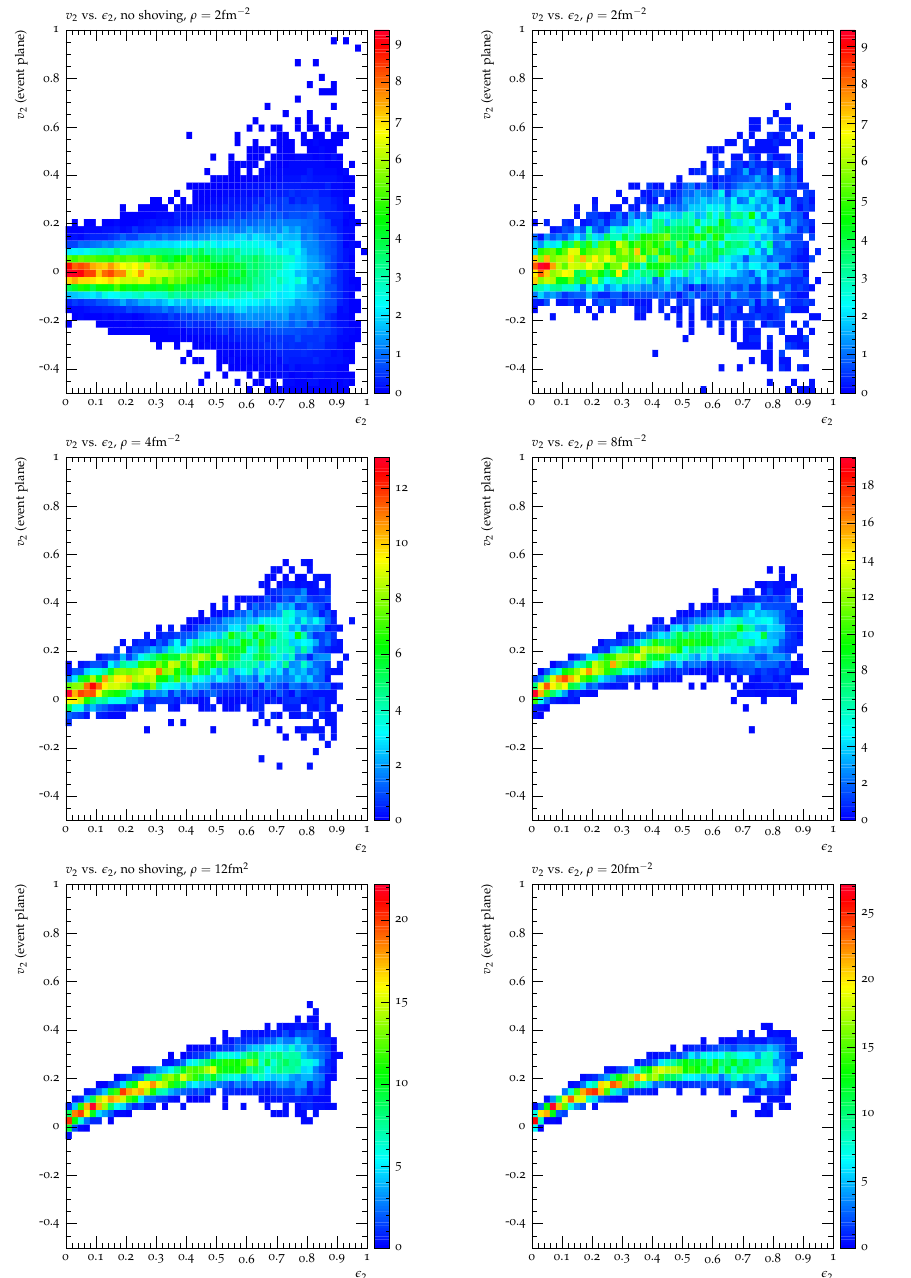
Figure 10 . The correlation between (cid:15) 2 and v 2 for no shoving, ρ = 2 fm − 2 (upper left) and with shoving for five different densities: ρ = 2 fm − 2 (upper right), ρ = 4 fm − 2 (middle left), ρ = 8 fm − 2 (middle right), ρ = 12 fm − 2 (lower left) and ρ = 20 fm − 2 (lower